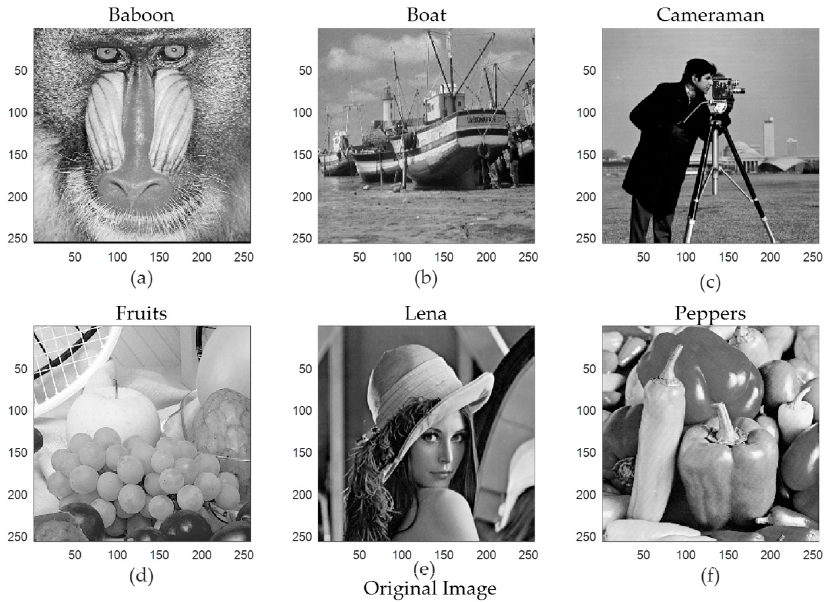
Figure 15. Original images ( a ) Baboon image, ( b ) Boat image, ( c ) Cameraman image, ( d ) Fruits image, ( e ) Lena image, ( f ) Peppers image.